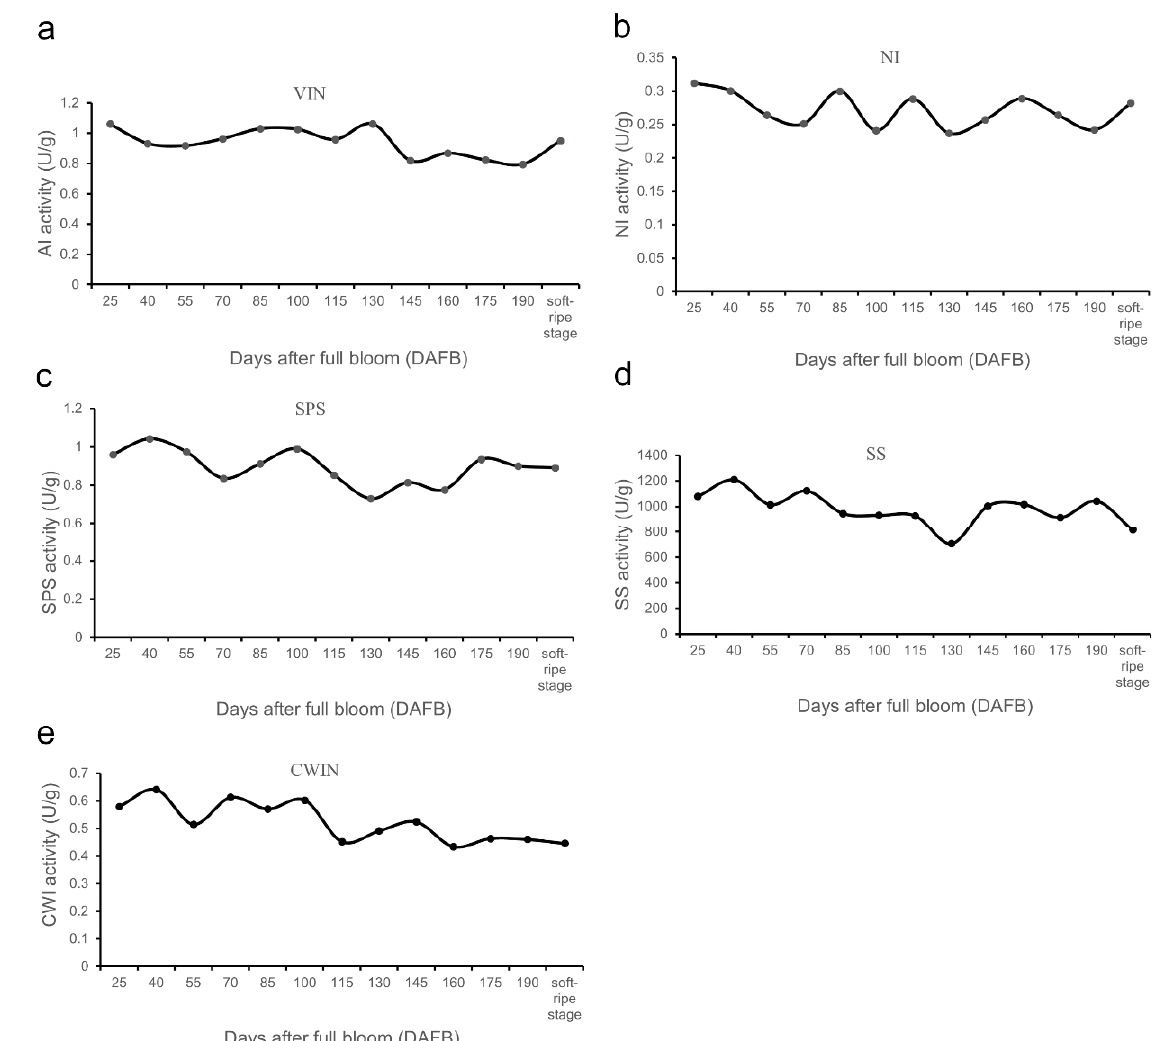
Figure 4. Changes in activities of sugar metabolism relative enzyme during fruit development of A. eriantha ‘Ganlv 1’, including VIN ( a ); NI ( b ); SPS ( c ); SS ( d ); CWIN ( e ).